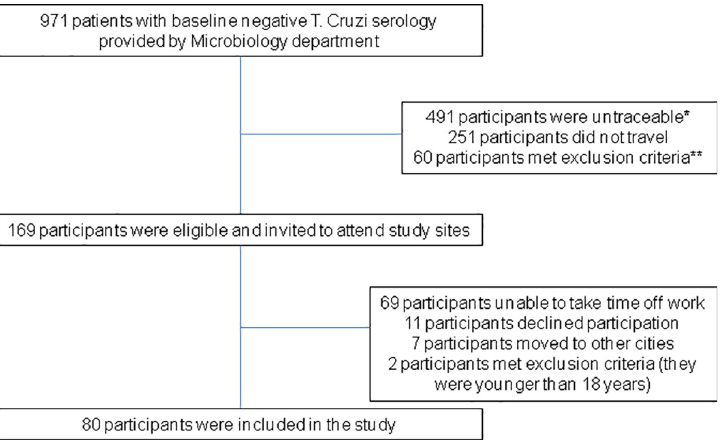
Fig 1. Participants flow diagram. � Participants were untreaceable due to: 308 no one answered the telephone, 86 telephone number did not exist, 26 wrong telephone number, 7 restricted in-coming calls, 20 had no telephone number in the medical record, 15 returned to home countries. �� Participants meeting exclusion criteria: 3 had discordant serology tests, 5 had seroreversion after Chagas’ disease treatment, 22 were deceased and 28 were younger than age